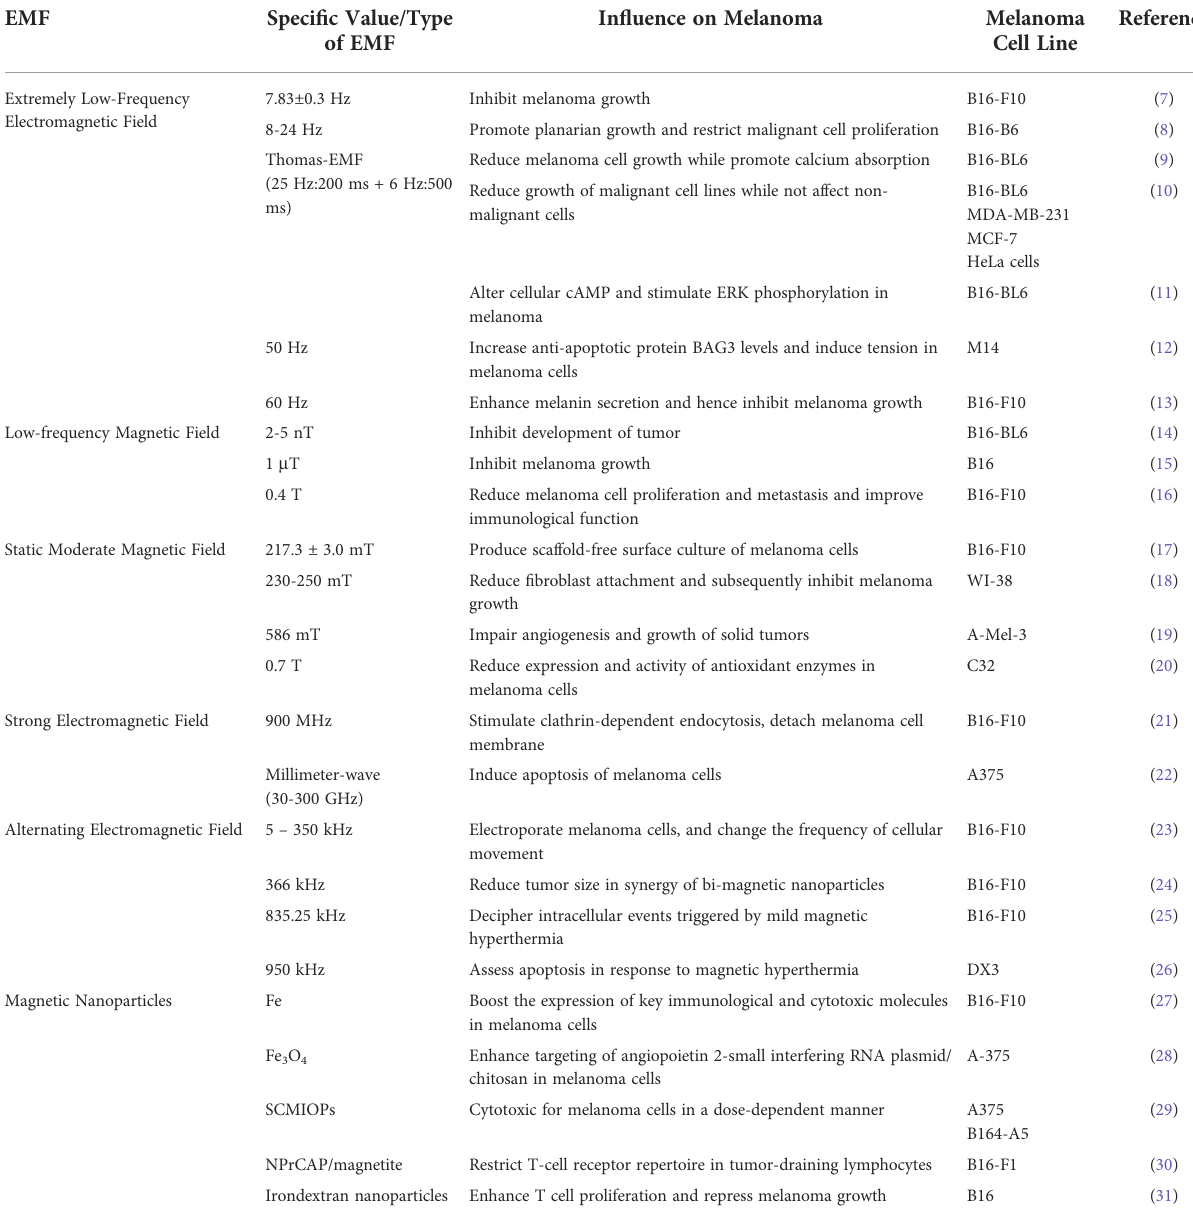
TABLE 1 Pre-clinical studies: the impact of different types of EMF on melanoma development.